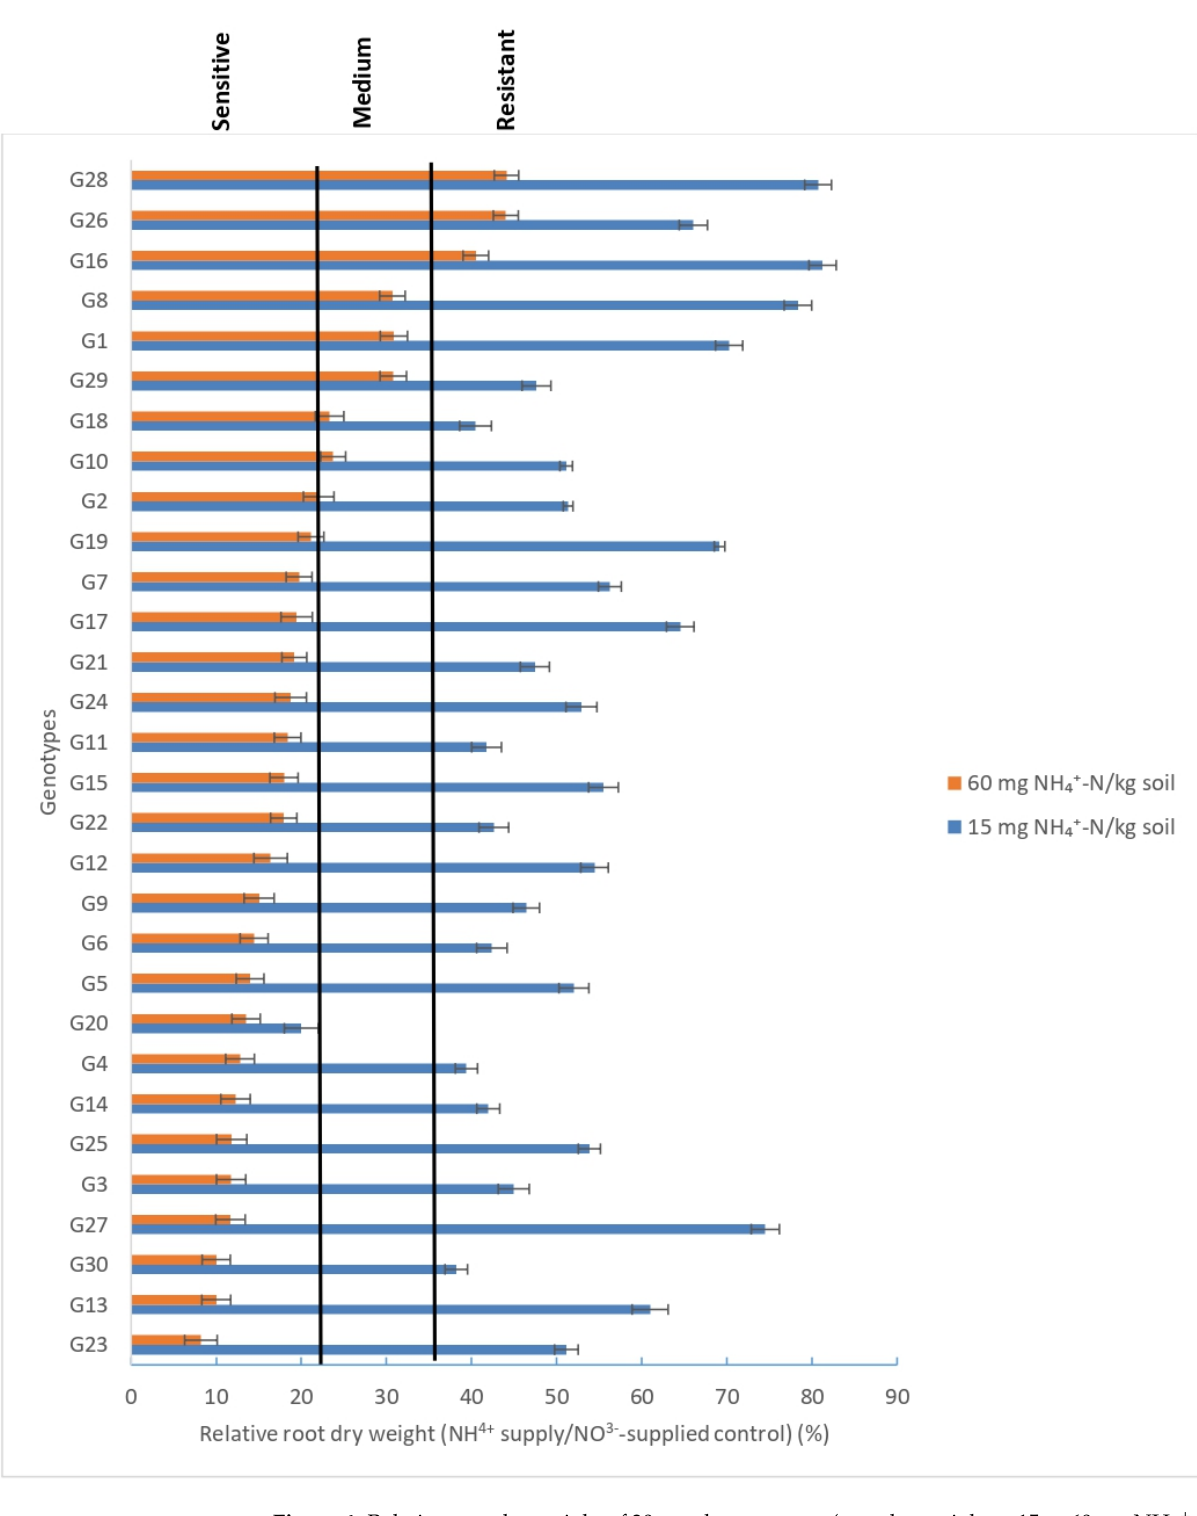
Figure 4. Relative root dry weight of 30 canola genotypes (root dry weight at 15 or 60 mg NH 4+ -N/kg soil) compared with the control (60 mg NO 3 − -N). The resistance intervals were defined by subtracting or adding the value of 2 standard errors (for the genotype main effect) from the median point for all the genotypes. Means ± SE (n =